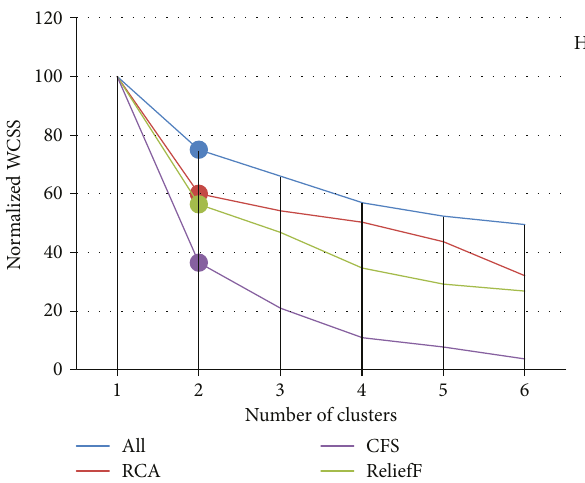
Figure 2: Validation of clustering for the HEART dataset.